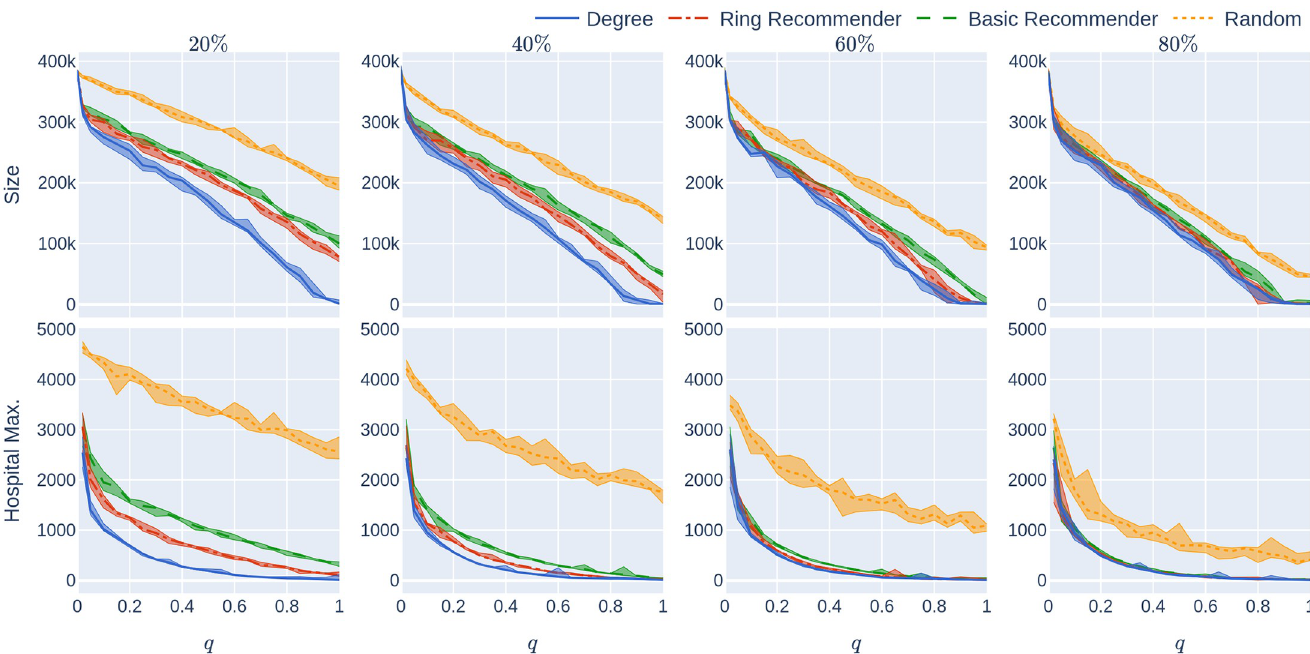
Fig 12. Experiment 2 on a less geometric network with many super-spreaders: Influence of the quarantine strictness q for various uptake percentages p % and the four uptake scenarios at infection rate β = 0.05. The underlying network is a 500,000-node GIRG with τ = 2.3 (more super-spreaders) and α = 1.3 (less geometric). Each column represents an uptake percentage. The x -axis shows the quarantine strictness q varying from 0 to 1 at step size 0.05. Simulations are done for the 21 values of q corresponding to these steps. There is an additional simulation point at 0.02 (in order to avoid division by 0 in the computation for HMax and still have a point close to 0). The y -axis shows the corresponding value of the KPI. The curves in each figure correspond to the different uptake scenarios, as labelled. For each parameter value, the plotted result is the median over 5 runs. The shaded region around the plot covers the results of all 5 simulations. The epidemic is started by infecting 100 individuals, chosen uniformly at random. Simulation is halted when there are no more exposed or infected vertices.